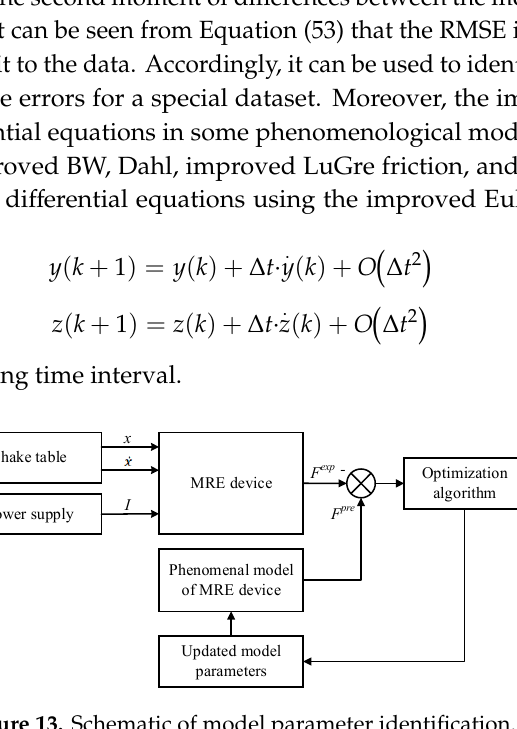
Figure 13. Schematic of model parameter identification.